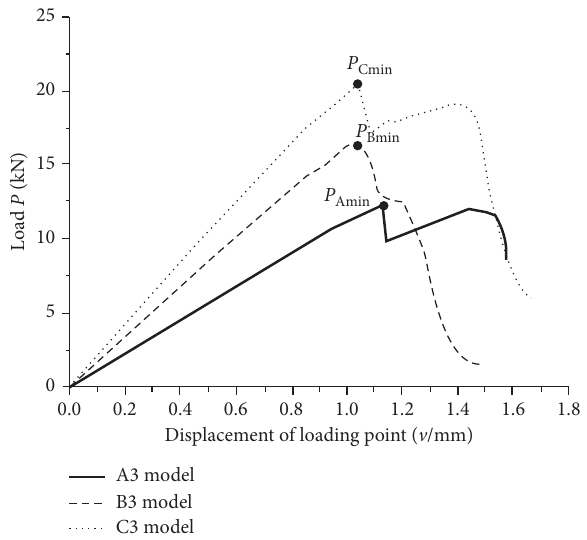
Figure 23: P - v curve of the CCNBD test.